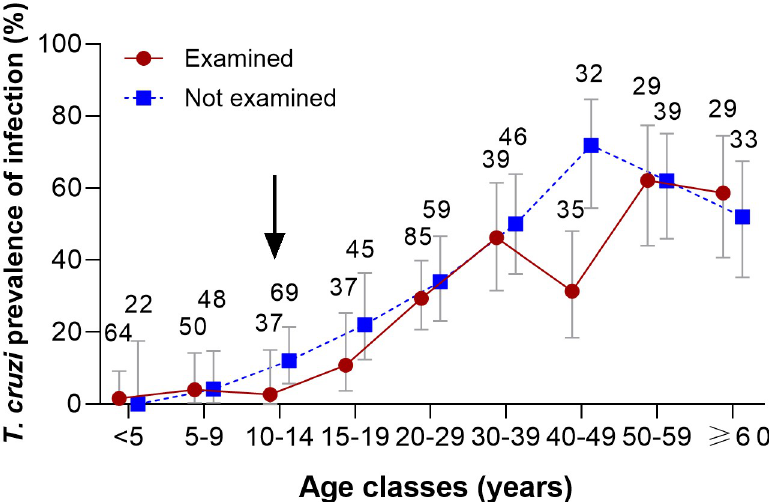
Fig 2. Age-specific seroprevalence of Trypanosoma cruzi in humans according to examined and self-reported status, Pampa del Indio, Chaco, 2017. The arrow indicates the occurrence of community-wide insecticide spraying and initiation of vector surveillance. Figures indicate the number of people examined for antibodies or reporting their serostatus for T . cruzi . Five people with unknown age were excluded.